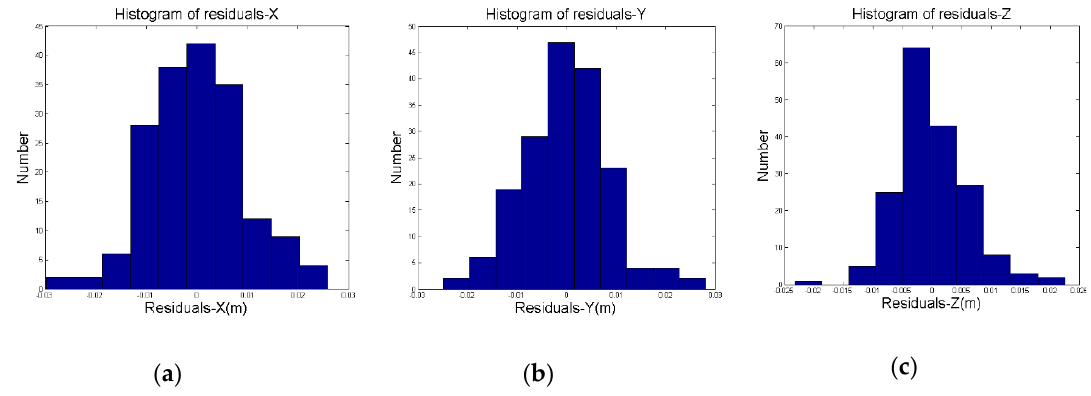
Figure 10. Residual distribution histogram of the CPs after calibration. ( a ) Residual distribution histogram in the X direction. ( b ) Residual distribution histogram in the Y direction; ( c ) Residual distribution histogram in the Z direction.